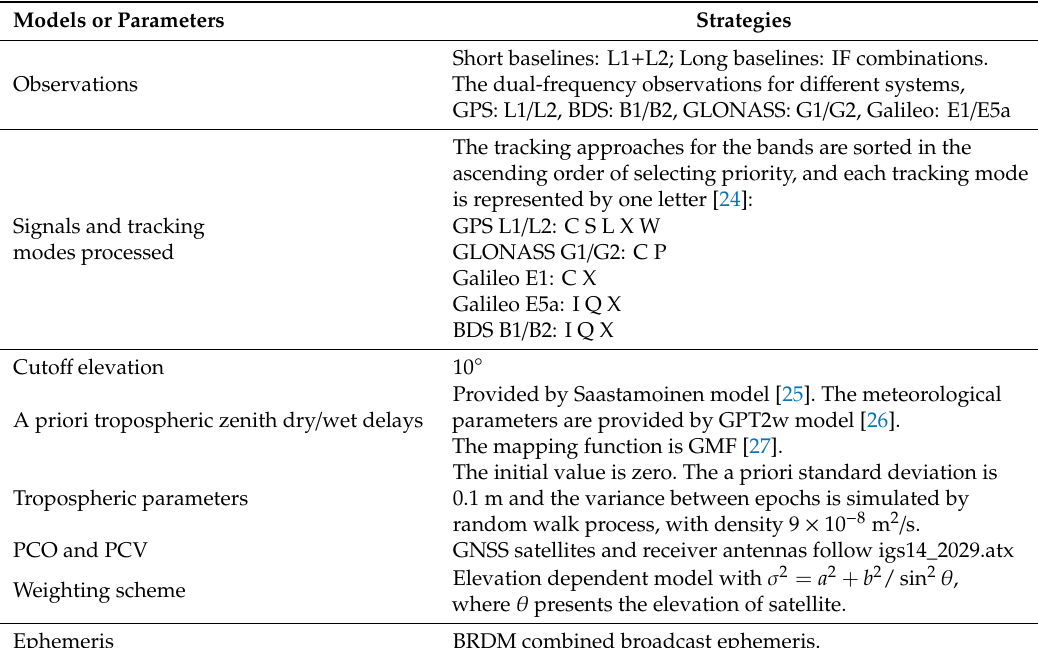
Table 2. Data processing